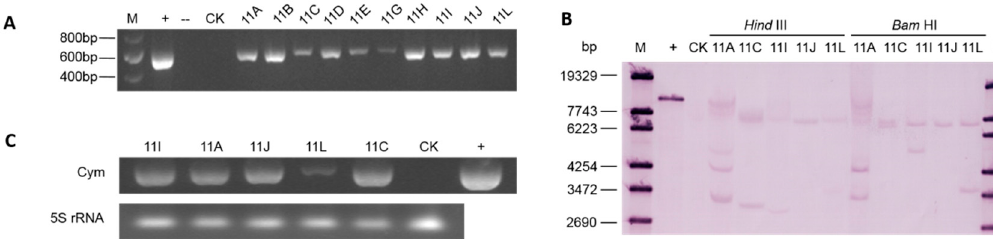
Figure 2. Molecular analysis of transgenic plants. ( A ) PCR analysis of the resistant regenerated plants. M, DNA ladder (Transgene, Beijing, China, cat. No.BM301); +, vector p33cym11 as positive control; --, H 2 O as blank control; CK, wild-type plant; Lane 1-10, resistant plants; ( B ) Southern Blotting